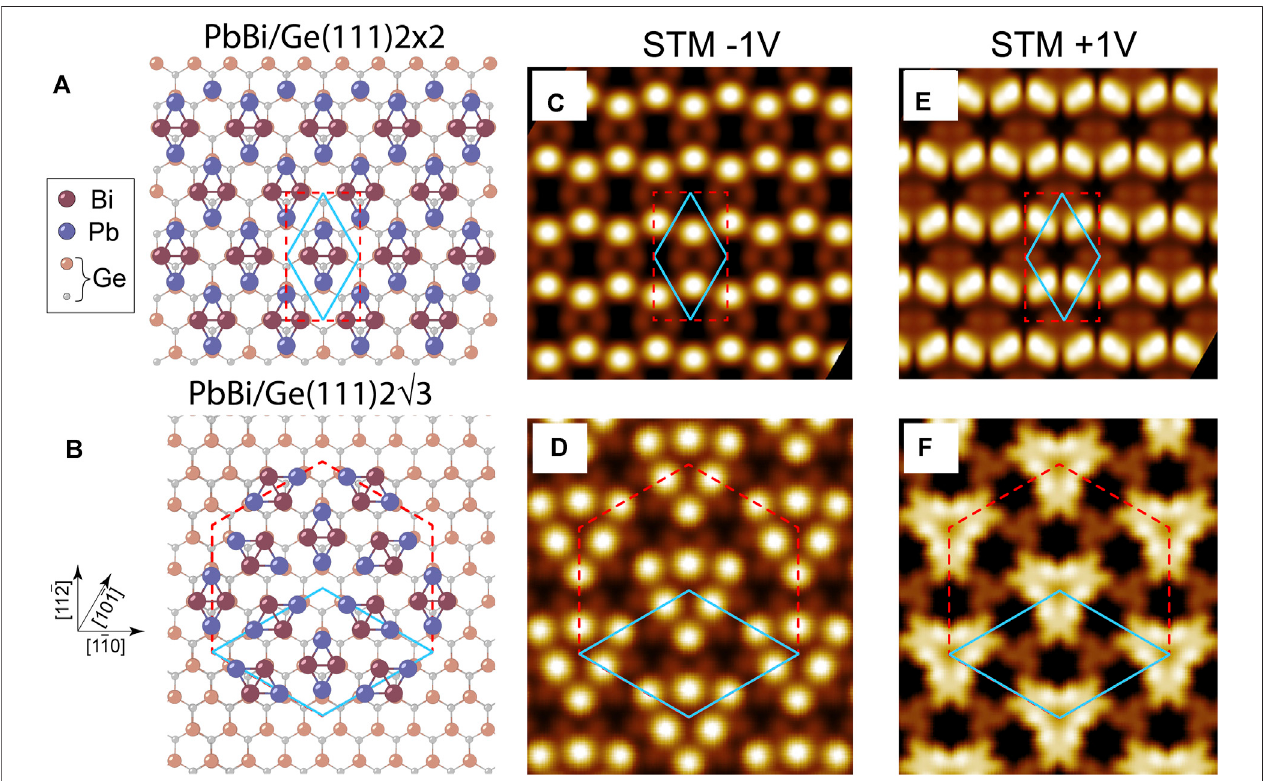
(cid:1)(cid:1) √ (cid:1)(cid:1) √ 3 × 2 3 -PbBi phases on Ge(111) and corresponding STM images simulated for fi lled states (cid:1)(cid:1) √ (cid:1)(cid:1) √ 3 × 2 3 -PbBi phase rhombus-like motifs are oriented according to